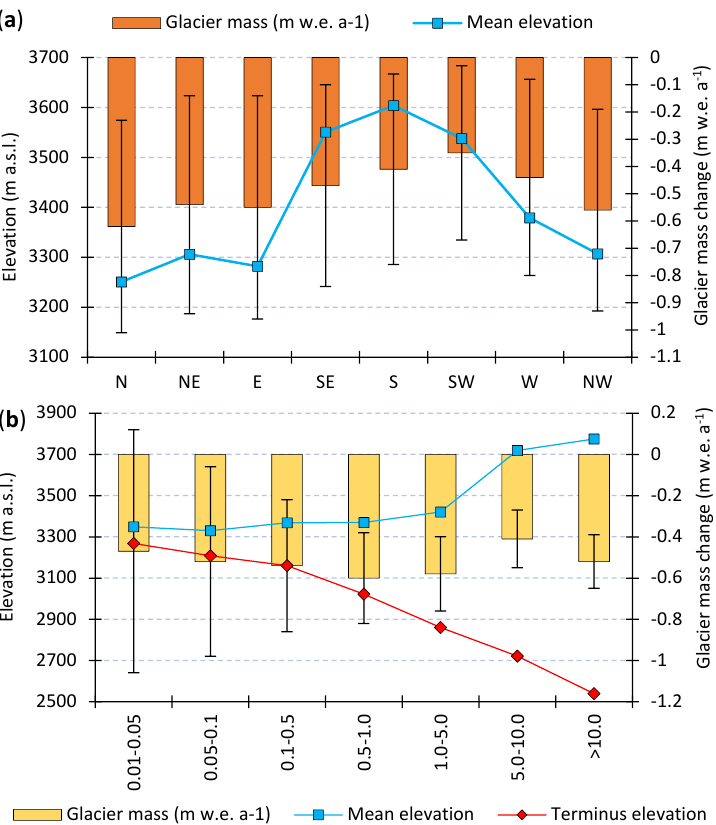
Figure 6. Changes in mean annual mass balance (m w.e. a − 1 ) vs. mean and minimum elevation according to the aspect ( a ) and seven size classes ( b ) for all Caucasus glaciers in 2000–2019. Vertical stems show an uncertainty estimation of the mean values.